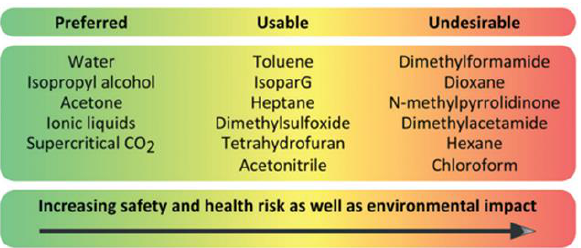
Figure 4. Preferred and undesirable solvents for membrane preparation. (Adapted with permission from Ref. [95]. Copyright 2014 Royal Society of Chemistry.)